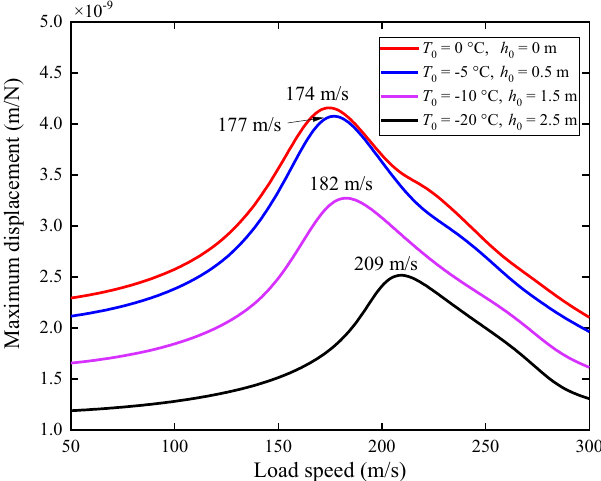
Figure 17. Load speed-maximum displacement curves of track/frozen ground system.